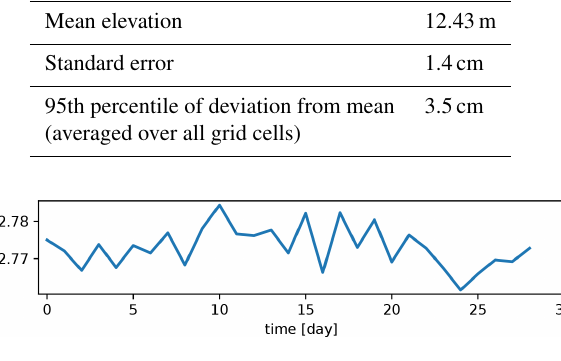
Figure 3. Time series of elevation at location ( x t ,y t ) (marked in Fig. 1) on the path that is assumed to be stable throughout the entire month. Elevation varies within less than